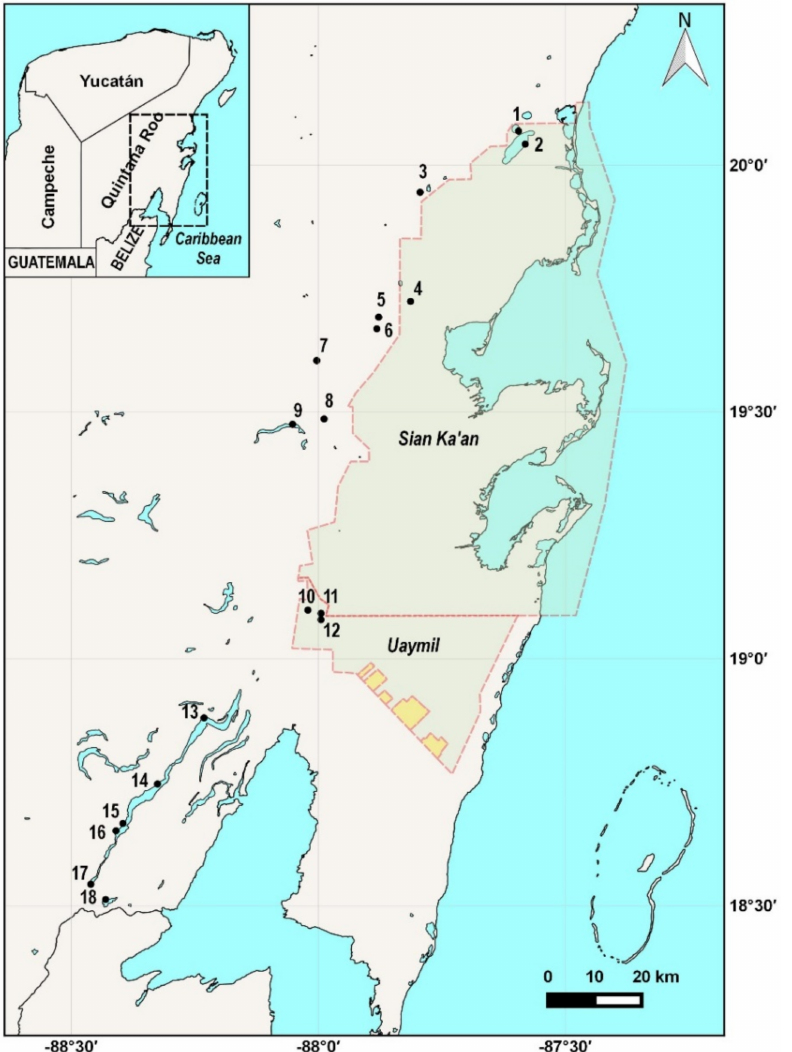
Figure 1. Study area, with the 18 sampling points: (1) Muyil, (2) Chunyaxche, (3) Km 48, (4) Santa Teresa, (5) Tres Reyes 2, (6) Tres Reyes 1, (7) Del Padre, (8) Chancah Veracruz, (9) Siijil Noh Ha, (10) El Toro, (11) Puct é 2, (12) Puct é -Cafetal, (13) Buena Vista, (14) Cayuco Maya, (15) Brujas, (16) Cocalitos, (17) Xul-ha, and (18) Huay Pix. The shaded area represents the Sian Ka’an reserve and the Uaymil protection